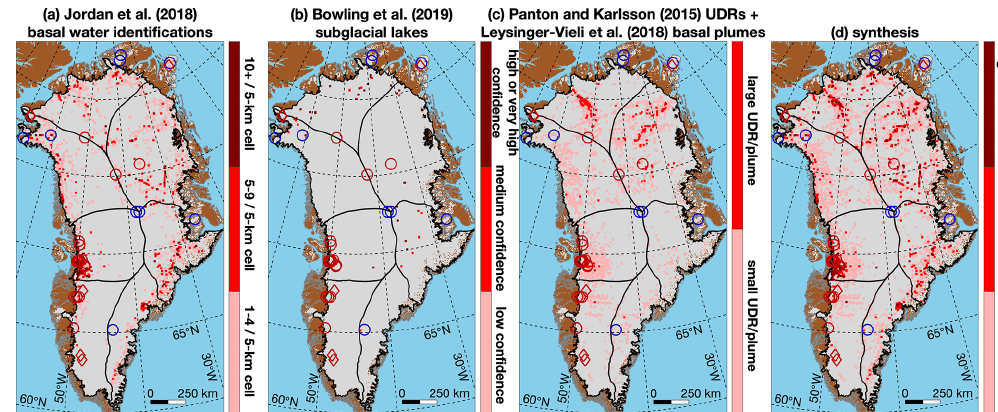
Figure 5. (a) Number of basal water identifications (Jordan et al., 2017) per 5km grid cell. (b) Subglacial lakes identified by Bowling et al. (2019). (c) UDRs/basal plumes identified by either Panton and Karlsson (2015) or Leysinger-Vieli et al. (2018). (d) Merged inferences of presence of basal water from an analysis of bed reflections or deep radiostratigraphy, respectively, in NASA airborne radar-sounding data ( M bw ). A value of 1–4 for M bw indicates low confidence; 5–9 indicates medium confidence; and > 10 indicates high confidence. Symbology follows Fig. 1, except that open symbols are used so that underlying inferences of basal water can be better